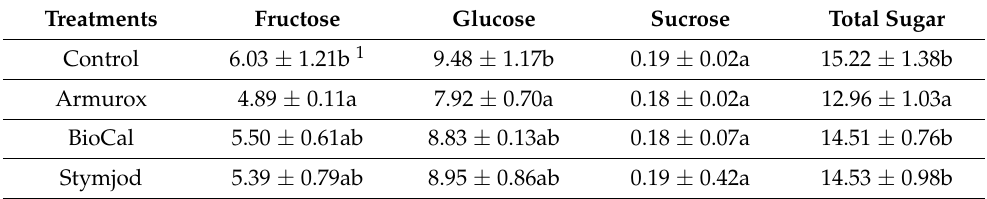
Table 8. Effect of foliar fertilization on the sugar content of highbush blueberry fruits in 2020.